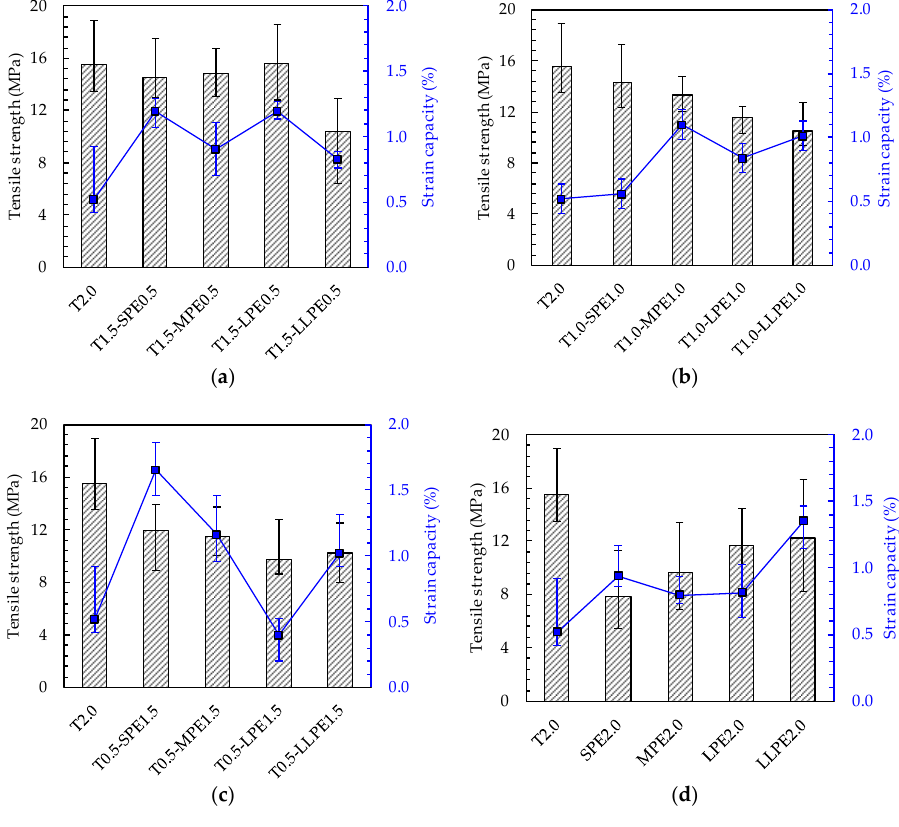
Figure 4. Tensile strength and strain capacity of ( a ) T0.5-PE1.5; ( b ) T1.0-PE1.0; ( c ) T1.5-PE0.5; and ( d ) PE2.0 series. Polymers 2018 , 10 , x FOR PEER REVIEW